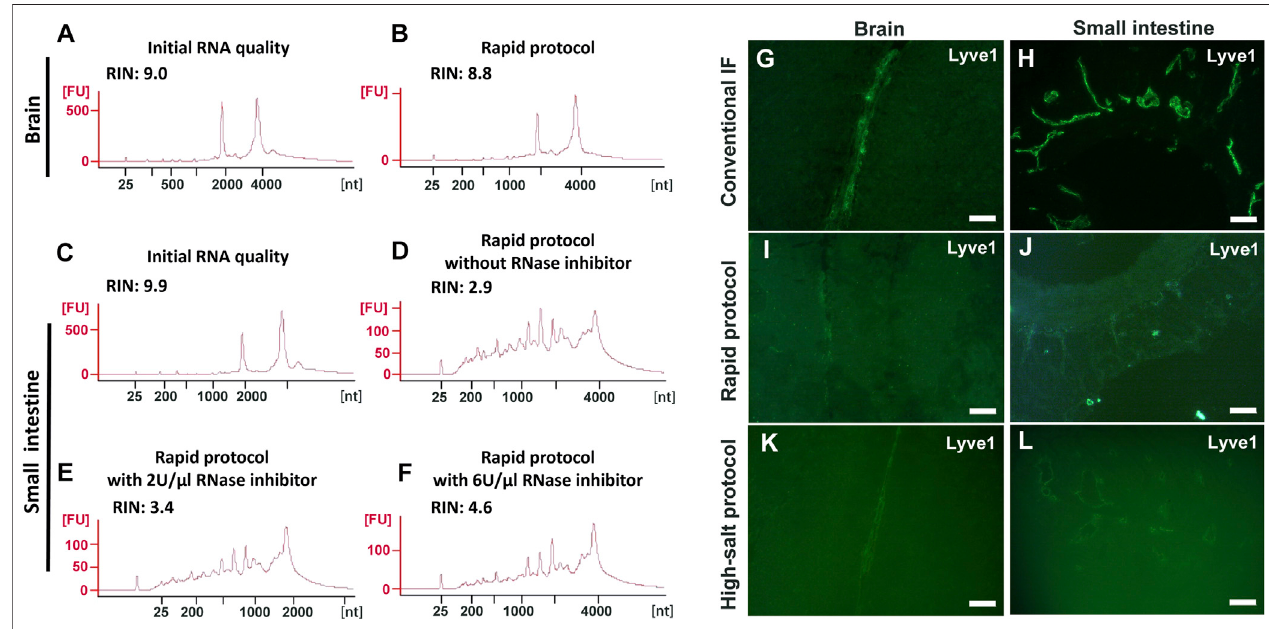
FIGURE 2 | Evaluation of the Rapid and high-salt immuno fl uorescence staining protocols with frozen sections of the mouse brain and small intestine. (A-F) RNA quality assessment for frozen sections after immuno fl uorescence labelling using the Rapid protocol. For the brain sections, the RNA quality after rapid immunolabelling (B) is comparable to the initial quality (A) . For the small intestine with a high endogenous RNase content, the RNA were severely degraded (D) even when high concentrations of RNase inhibitor were present (E – F) . (G-L) Quality of IF images with the mouse brain (G,I,K) or the small intestine (H,J,L) . Here, anti-Lyve1 was used to identify lymphatic vessels. With both protocols (I – L) , the image quality in both tissues ispoor when compared with the control (G,H) . Scale bar: 50 µm (G,I,K,L) and 100 µm (H,J) .